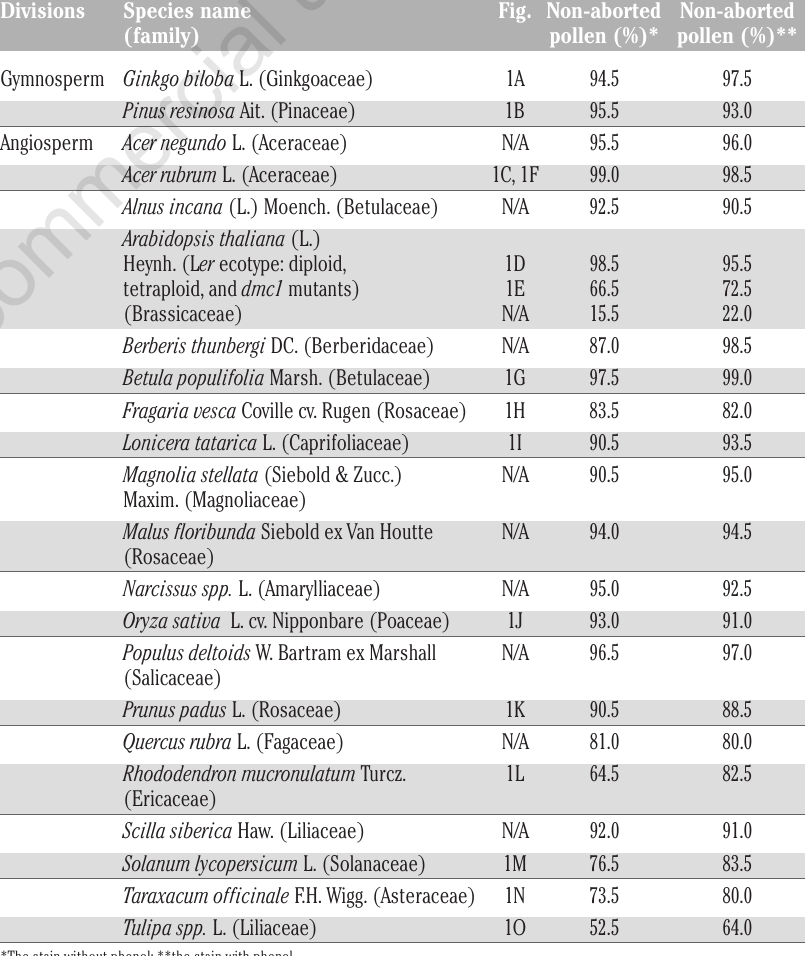
Table 1. A list of plant species tested.